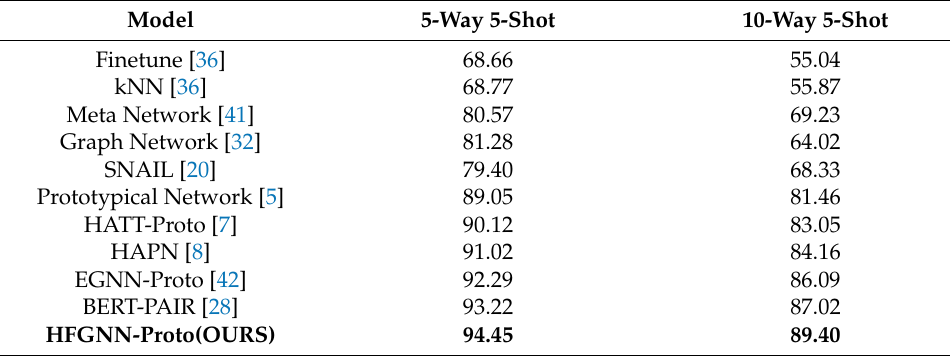
Table 4. Comparison of classification accuracy (%) on FewRel.